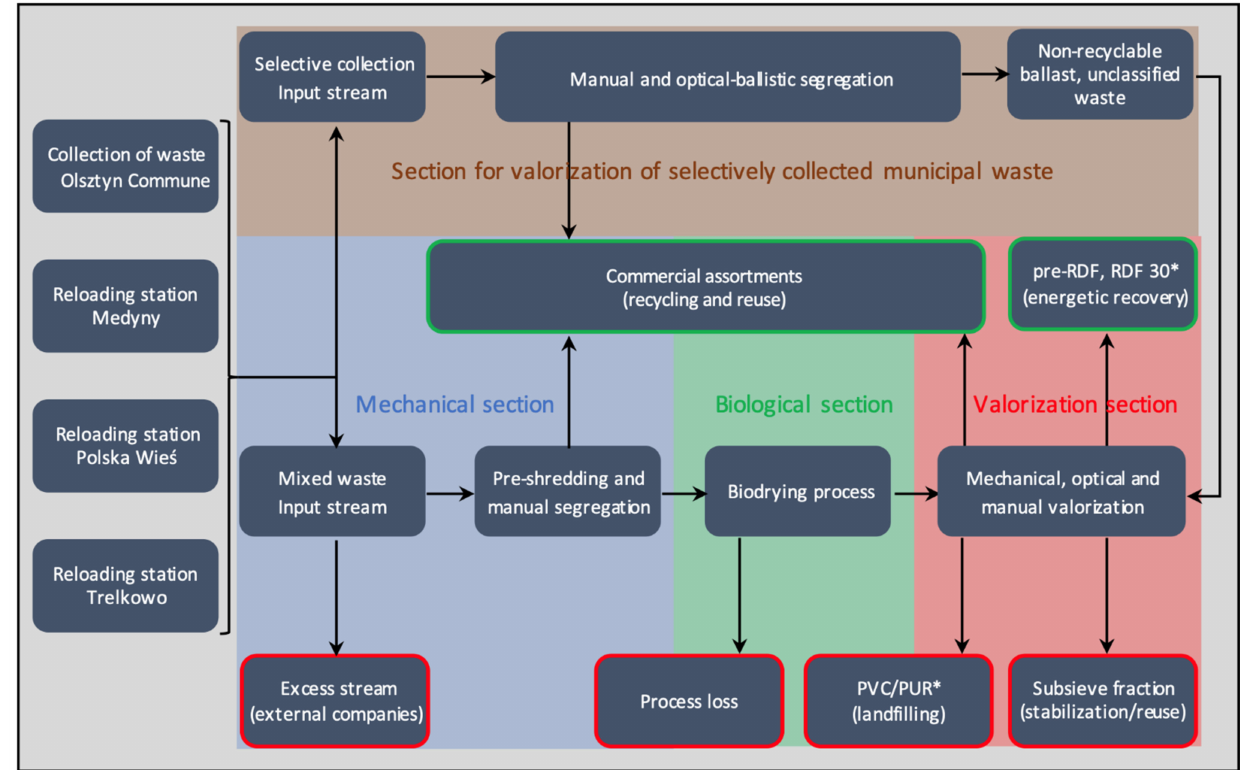
Figure 3. Technological flow of the Municipal Waste Management Plant in Olsztyn, Poland; * RDF—Residual Derived Fuel, RDF 30—Residual Derived Fuel of <30 mm, PVC—Polyvinyl chlorine,